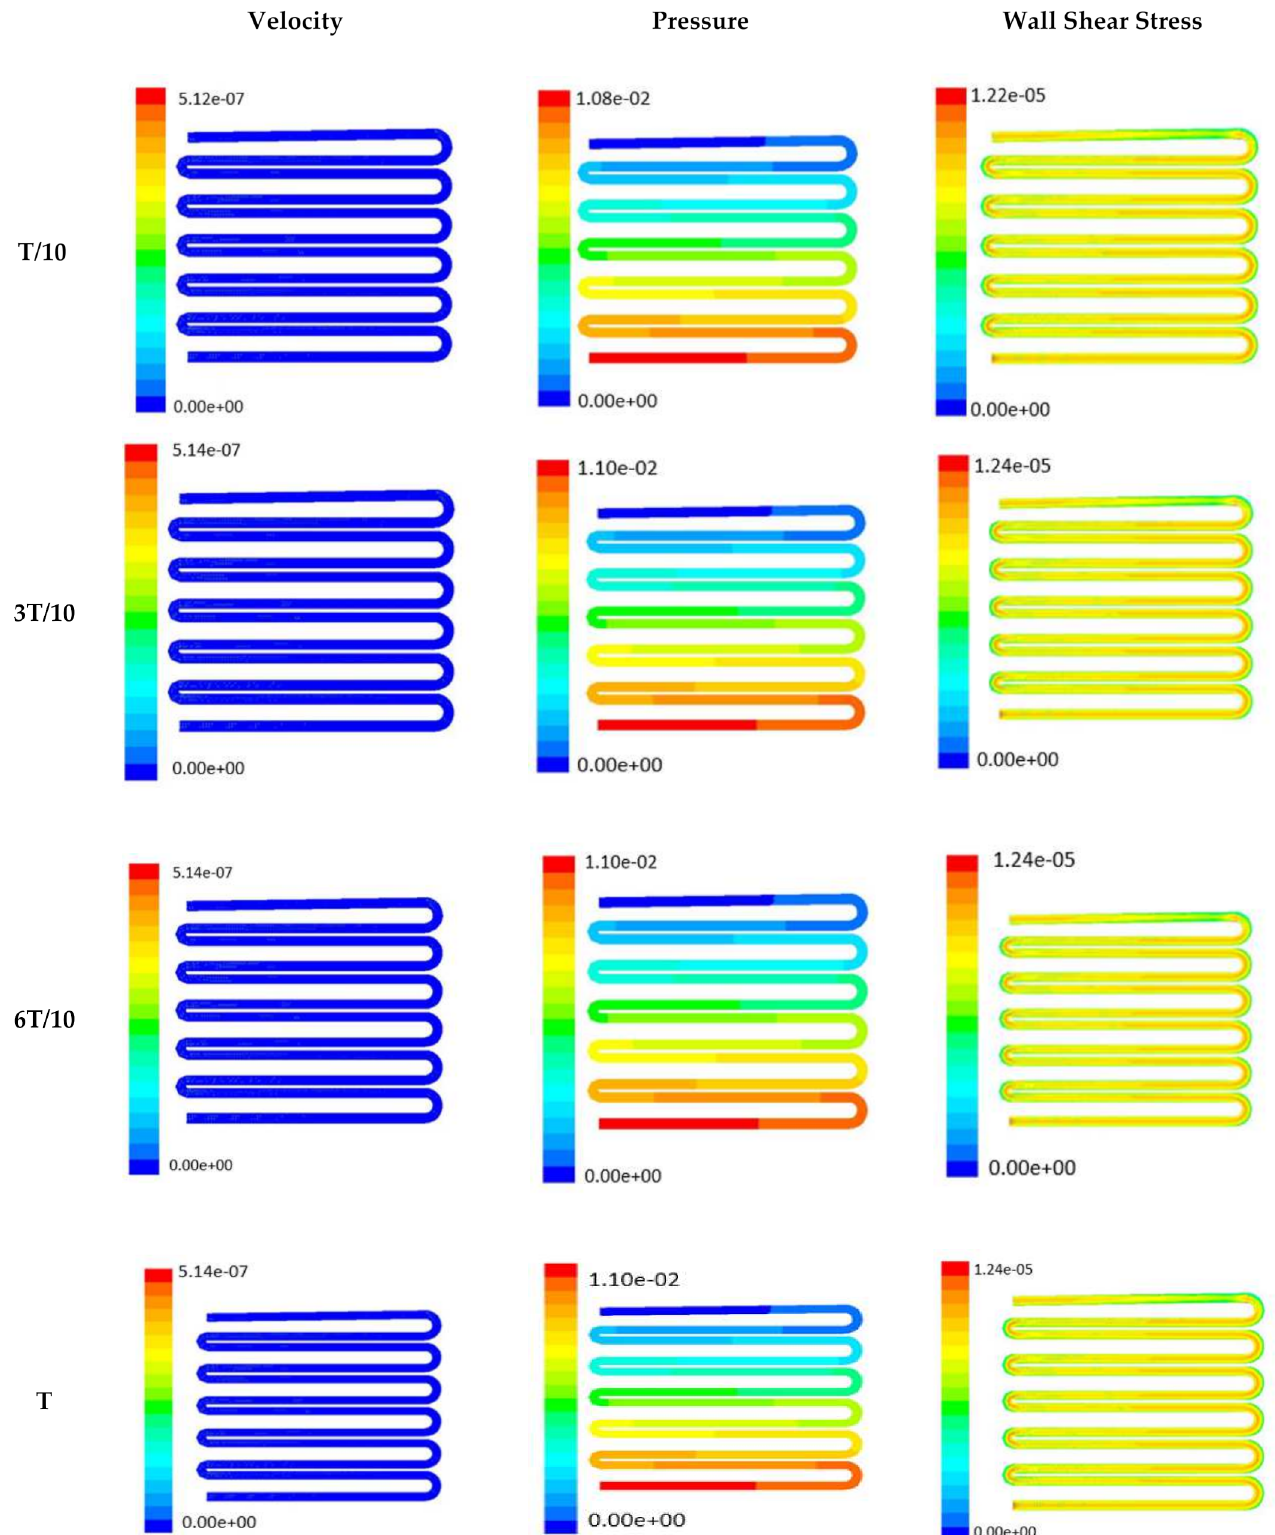
Figure 8. Numerical simulation of fluid flow inside the design 2 at flow rate of 20 µ L/min. The different time step was taken to understand the profile of velocity, pressure and wall shear stress along the